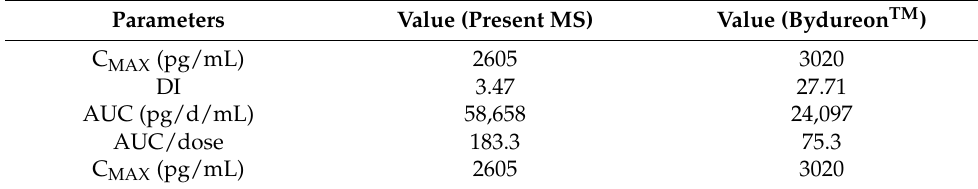
Table 4. Non-compartmental model parameters of pharmacokinetic profiles of the microspheres of exenatide microspheres of the present study and Bydureon TM in rhesus monkeys. Parameters Value (Present MS) Value (Bydureon TM )